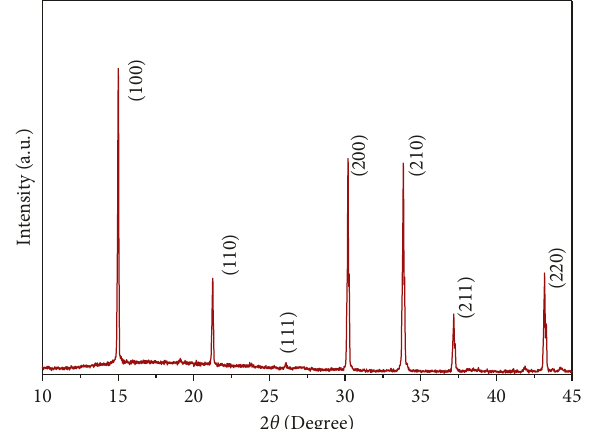
Figure 2: XRD spectra of the MAPB